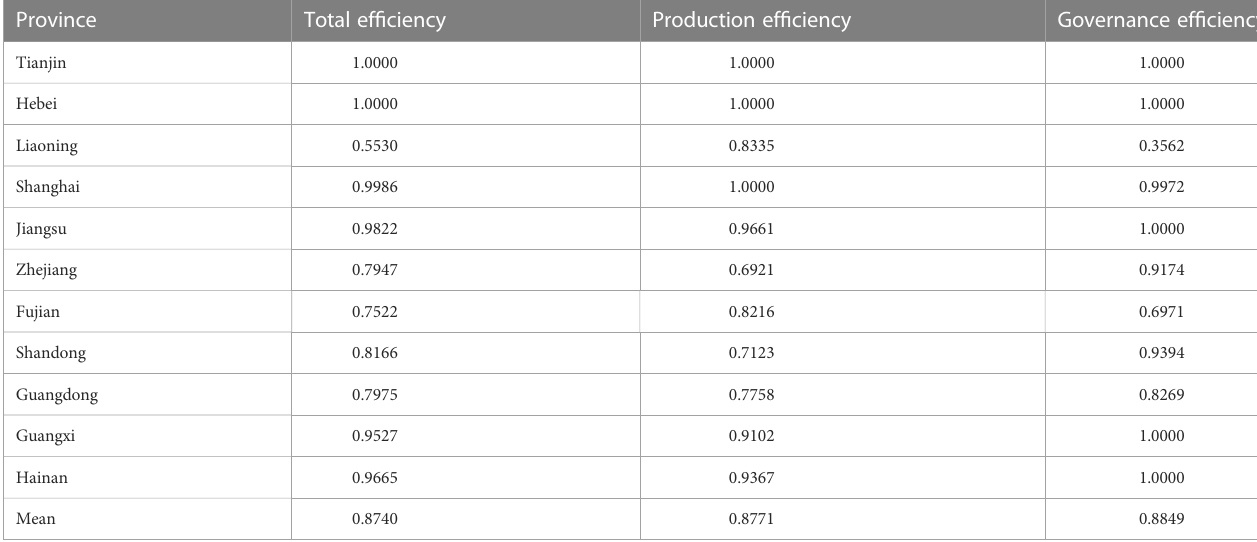
TABLE 3 Mean values of marine green economy ef fi ciency at different stages in each province.